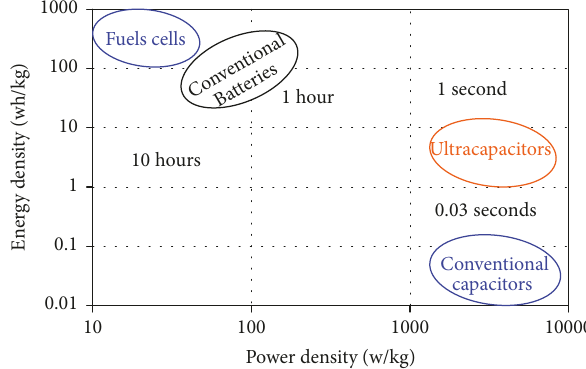
Figure 2: Ragone diagram of energy storage sources.